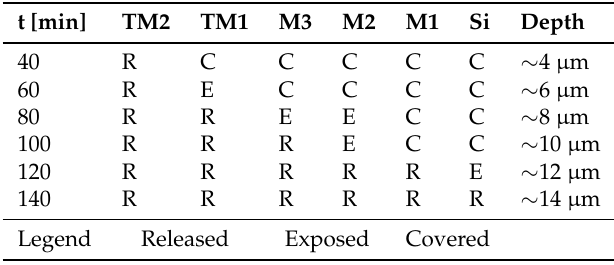
Table 3. Approximate release depth vs. time.